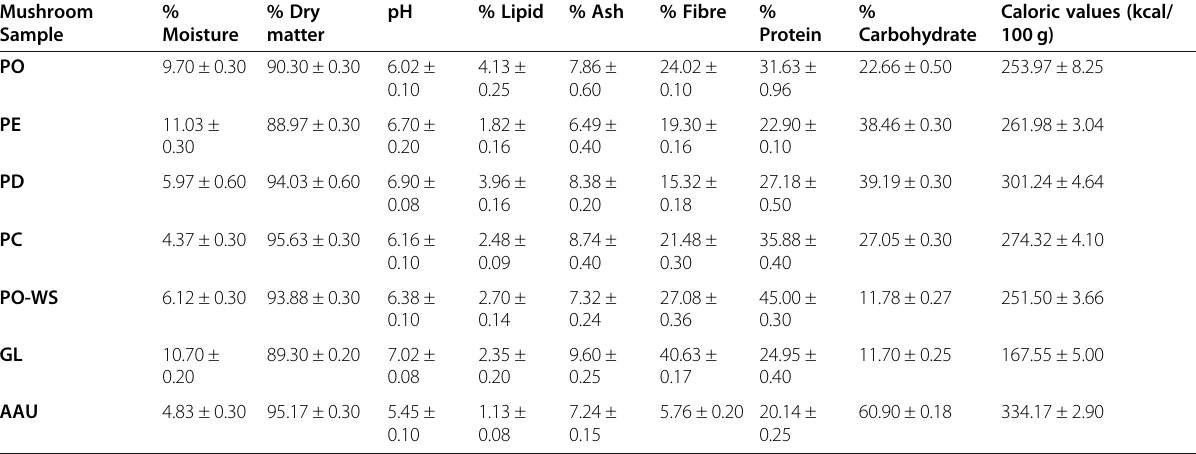
Table 2 Proximate composition of selected Bangladeshi cultivated mushrooms Mushroom